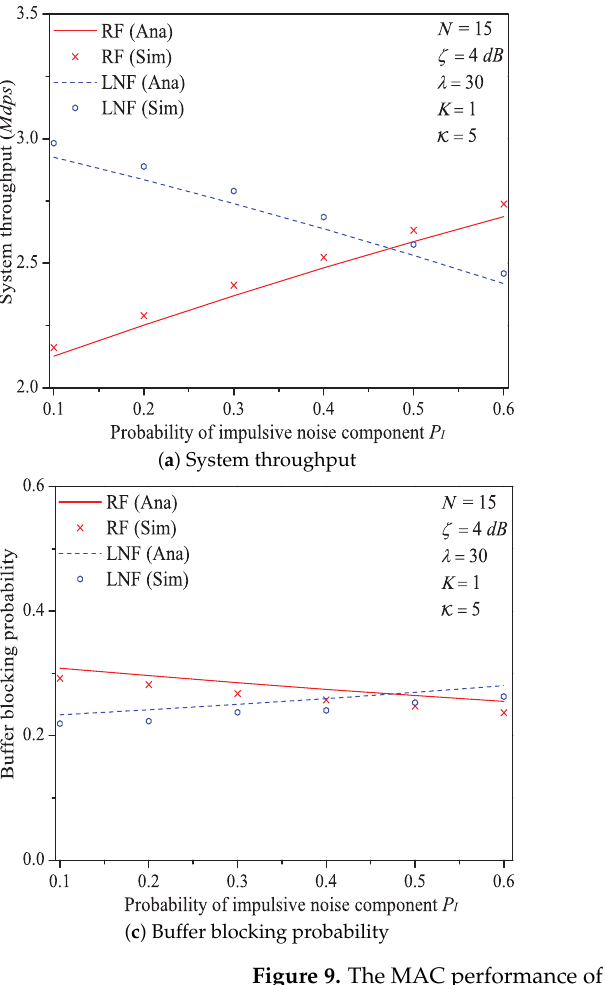
Figure 9. The MAC performance of 1901 protocol with different P I .